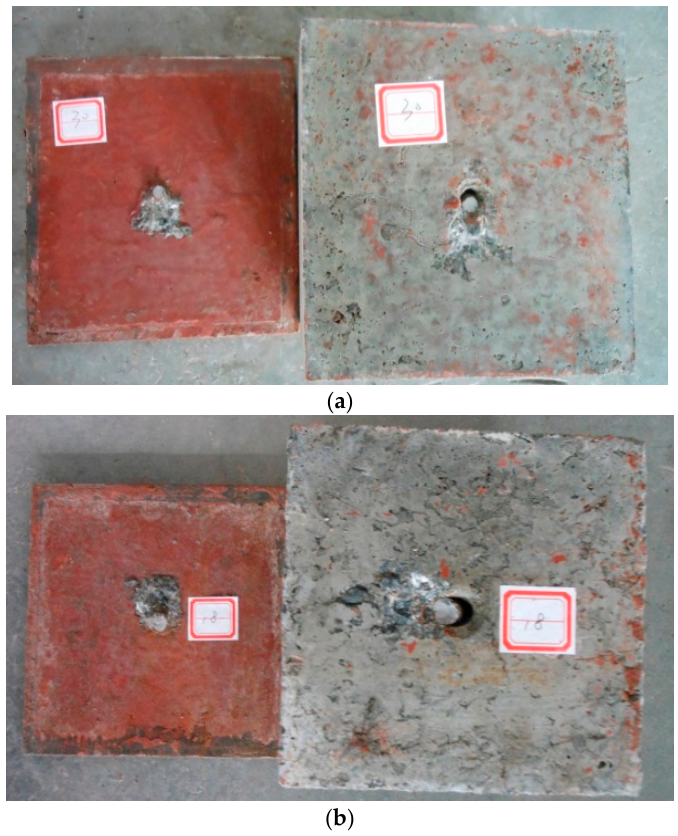
Figure 5. Typical failure mode of the single stud shear connector specimen: ( a ) Specimen W10.0-5; ( b ) Specimen W13.0-10.